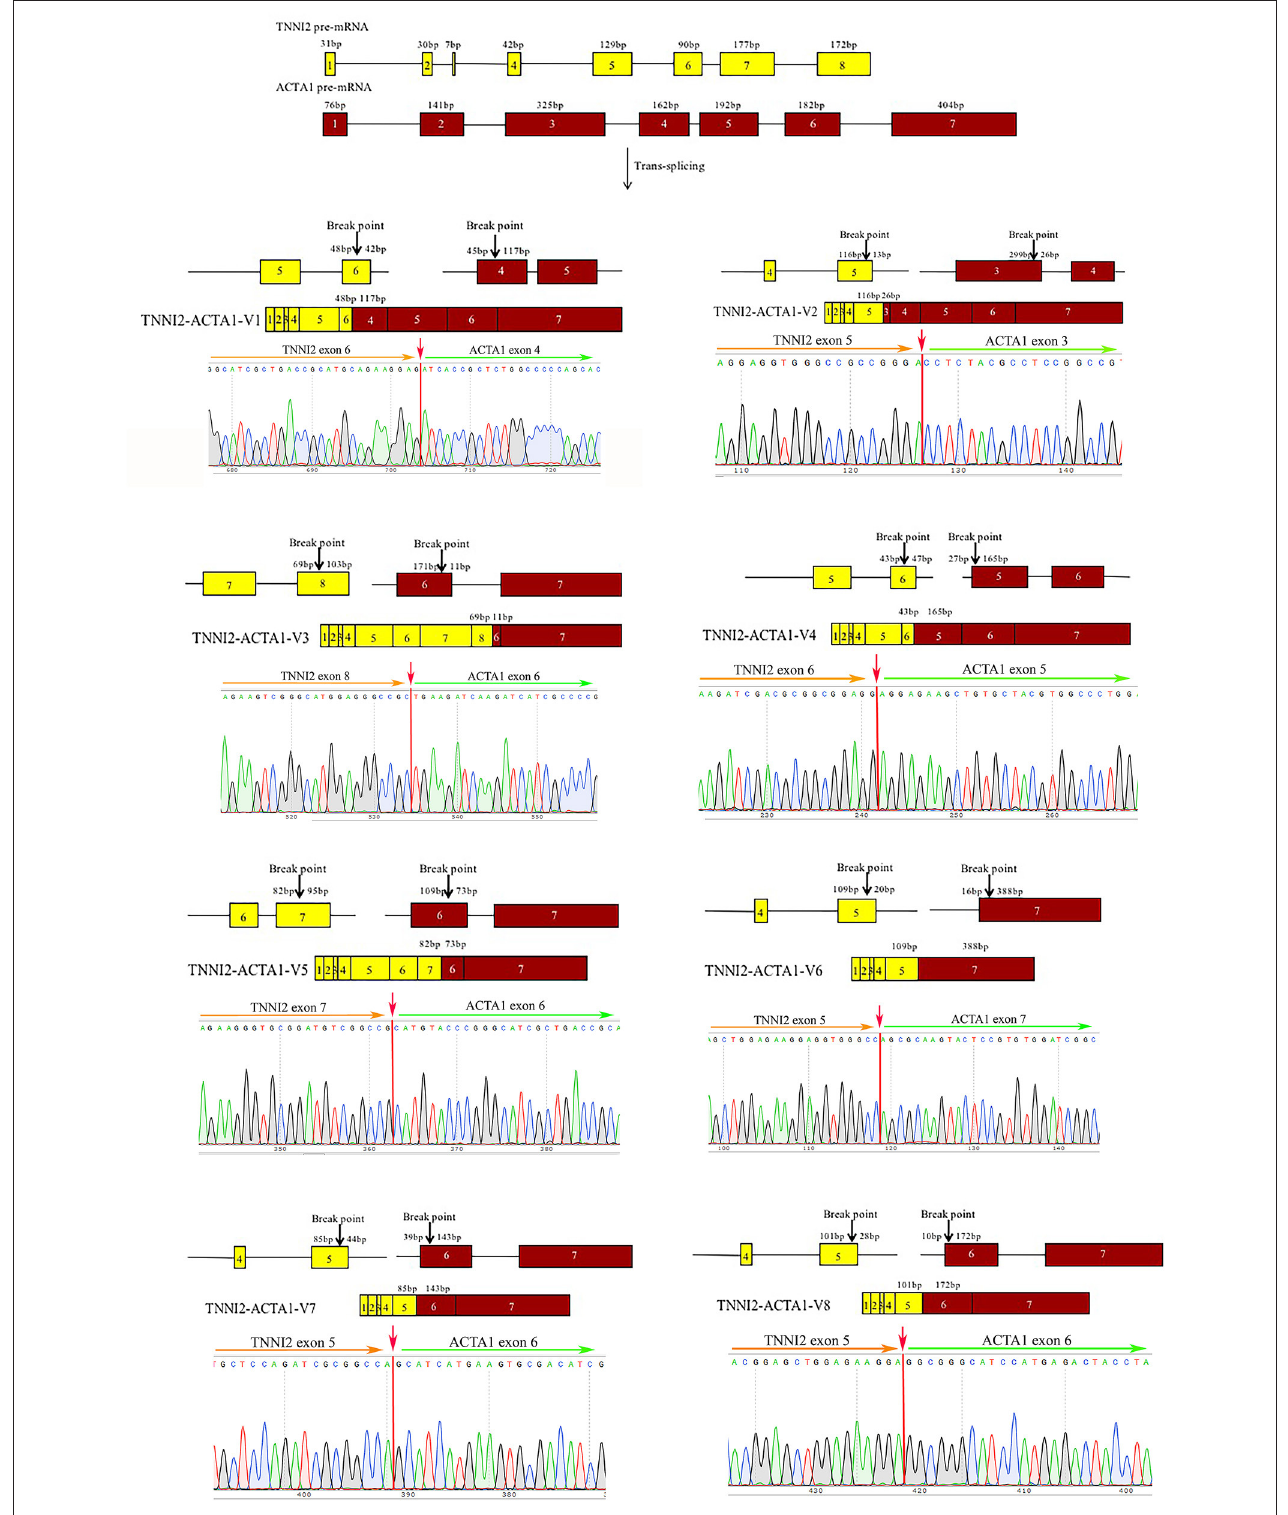
FIGURE 3 | Structure and Sanger sequencing validation of chimeric RNA TNNI2-ACTA1 transcript variants V1–V8. The red line marks the fusion junction site. The yellow boxes indicate exons of TNNI2. The red boxes indicate exons of ACTA1. Yellow and green arrows indicate the direction of transcription.